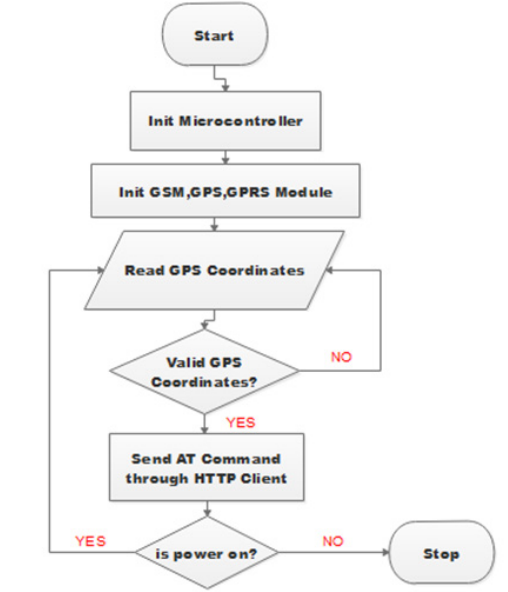
Fig. 1. Proposed Tracking Algorithm (Flow